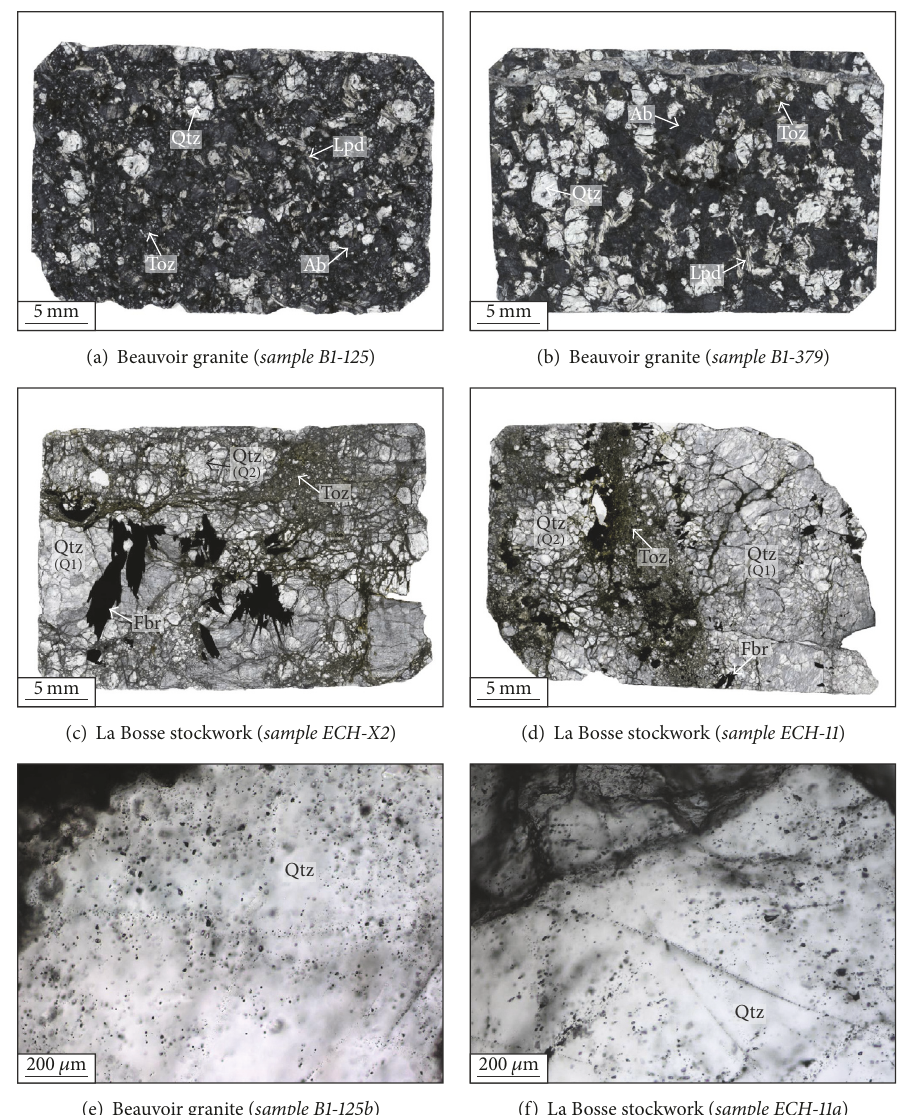
Figure 5: Photographs of thick sections of the studied samples from the Beauvoir granite ((a), (b)) and the La Bosse stockwork ((c), (d)). Representative microphotographs of fluid inclusions observed in primary quartz from the Beauvoir granite (e) and the La Bosse stockwork (f) are shown. Note the density of disseminated fluid inclusions within the primary quartz and the presence of secondary fluid inclusions planes. Ab: albite; Fbr: ferberite; Lpd: lepidolite; Qtz: quartz; Toz: